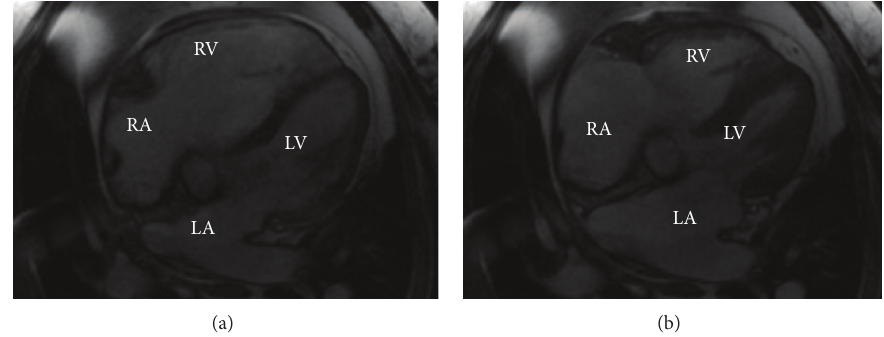
Figure 3: Long axis cardiac magnetic resonance imaging prior to surgical correction. Panel (a) demonstrates severe right ventricular enlargement during end-diastole of the cardiac cycle. Panel (b) demonstrates severe right atrial enlargement during end-systole of the cardiac cycle. RA: right atrium; RV: right ventricle; LA: left atrium; LV: left ventricle.